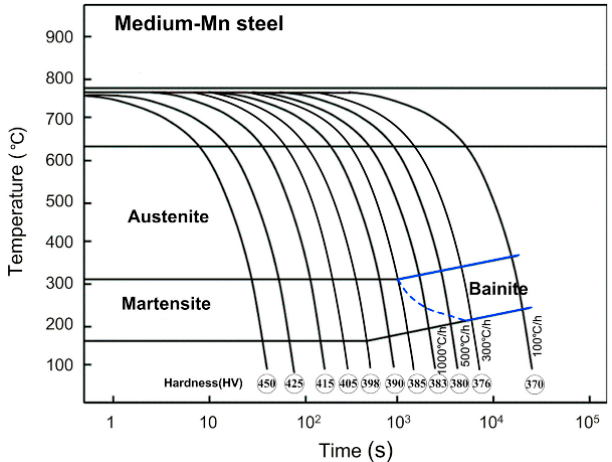
Figure9. Continuouscoolingtransformation(CCT)diagramfor5Mnsteel(Reproducedwithpermission Figure 9. Continuous cooling transformation (CCT) diagram for 5Mn steel (Reproduced with from Elsevier permission from Elsevier [103]).